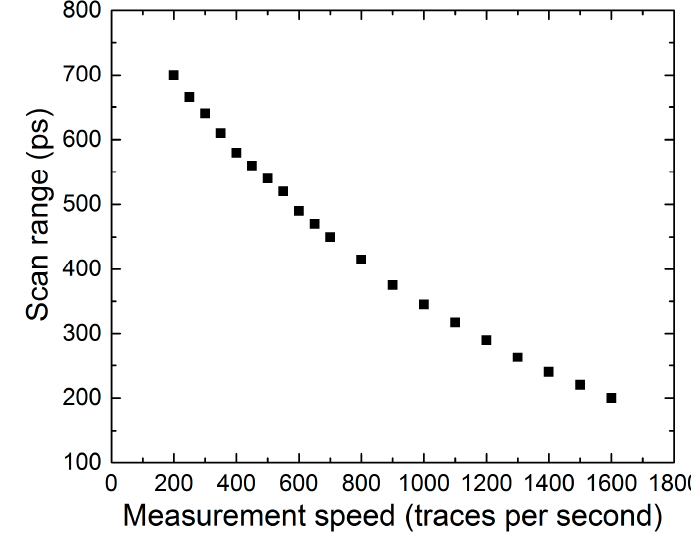
Figure 6. Scan range of the ECOPS system vs. measurement speed.